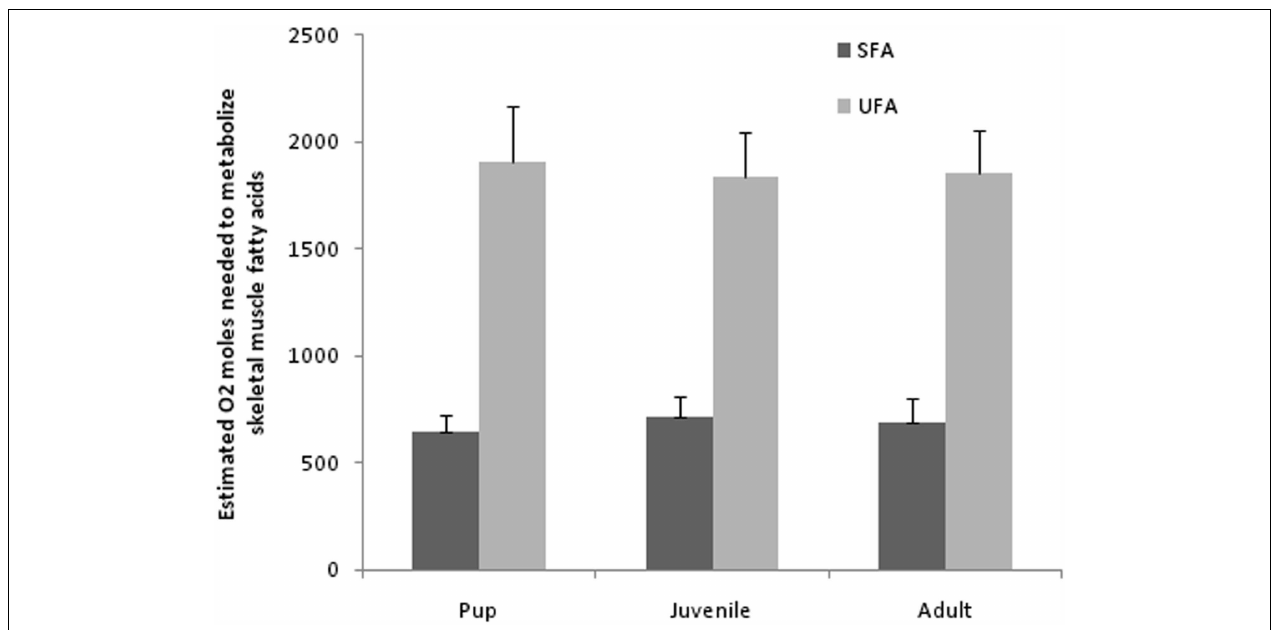
percent of fatty acids recovered. note: fatty acids include (SFA; C14:0–24:0), monounsaturated (MUFA; 14:1 n − 5, 16:1 n − 9, 16:1 n − 7, 18:1 n − 9, 18:1 n − 7, 18:1 n − 11, 20:1 n − 9, 20:1 n − 7, 22:1 n − 11, 22:1 n − 9, 24:1 n − 9), and polyunsaturated (PUFA; 18:2 n − 6, 18:3 n − 6, 18:3 n − 3, 18:4 n − 3, 20:2 n − 9, 20:2 n − 6, 20:3 n − 6, 20:4 n − 6, 20:3 n − 3, 20:4 n − 3, 20:5 n − 3, 22:4 n − 6, 22:5 n − 6, 22:5 n − 3, 22:6 n −